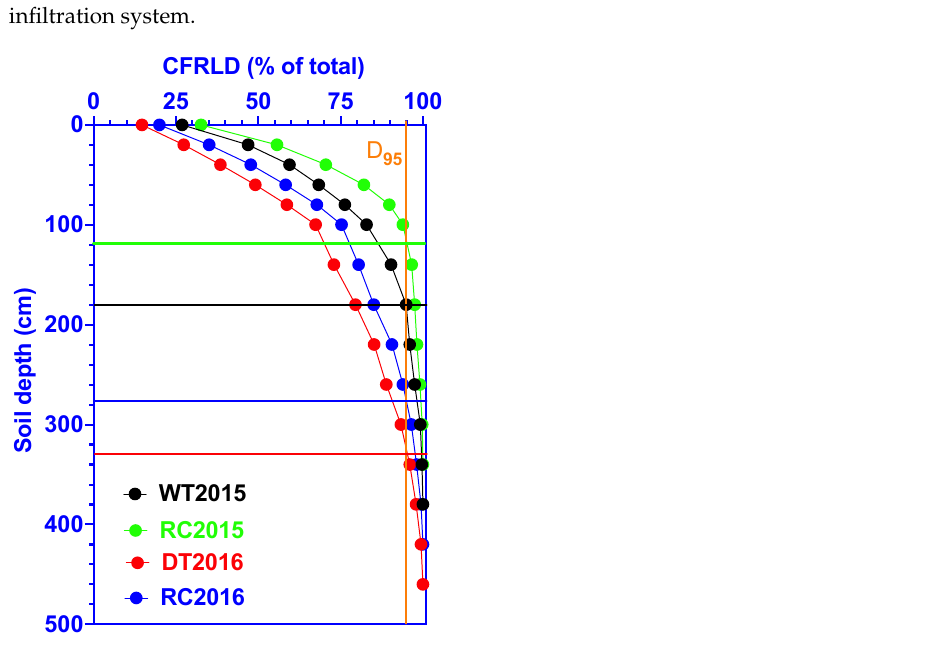
Figure 5. Comparison of cumulative fine-root length density in Robinia pseudoacacia forest stands of different treatments in a wet year of higher-than-average rainfall (2015) and a dry year of lower- than-average rainfall (2016). Data points represent average fine-root length densities in the indicated soil layers. The intersection of horizontal lines (with different colors) and vertical lines D 95 indi- cates soil depth above which 95% of fine-root length density occur. WT2015 is wet year of 2015 without in situ rainwater collection and infiltration system; RC2015 is wet year of 2015 with in situ rainwater collection and infiltration system; DT2016 is dry year of 2016 without in situ rainwater collection and infiltration system and RC2016 is wet year of 2016 with in situ rainwater collection and infiltration